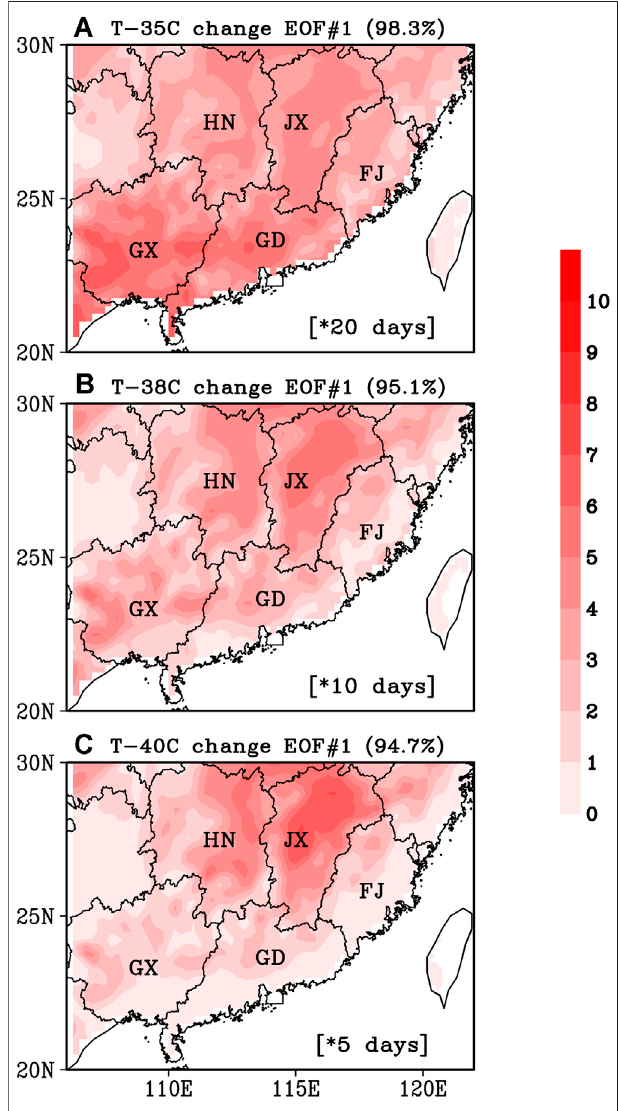
FIGURE 3 | The spatial patterns of the fi rst EOF mode at three different T-levelsbyperformingInter-modelEOFanalysisona100-yearschangeofthe EHTDsbetweenhistorical1980 – 1999periodandRCP8.52080 – 2099period. To gain better visibility, the patterns in the fi gures are the results of dividing a factor shown on the bottom into the real variable data.